Question: Produce a descriptive caption suitable for publication.
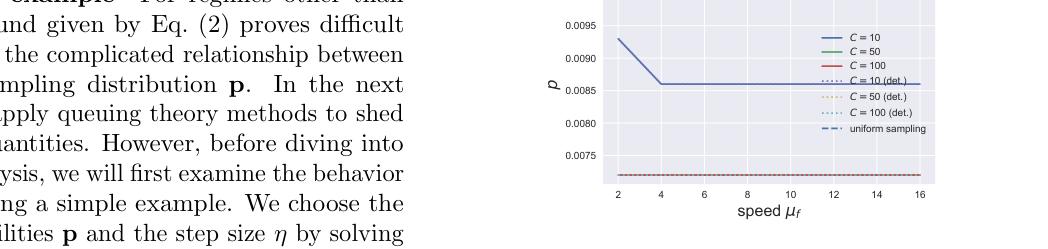
Answer: Optimal sampling probability p as a function of the speed for different concurrency levels. The num- ber of nodes is fixed to n = 100 nodes.